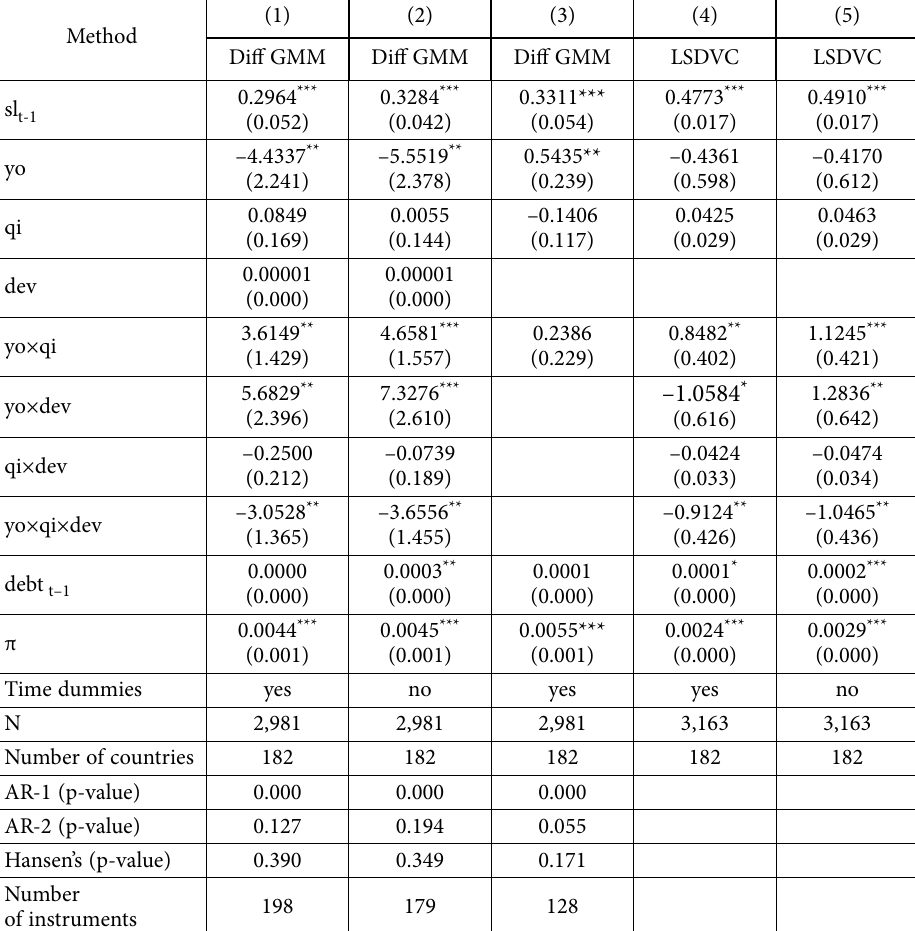
Table 3. Estimation